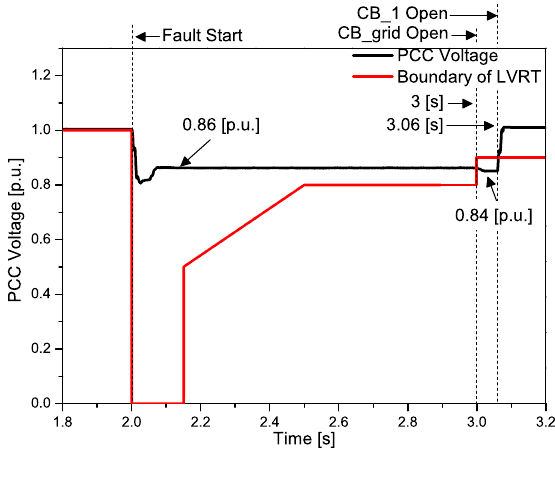
Figure 11. PCC voltage with an SFCL.